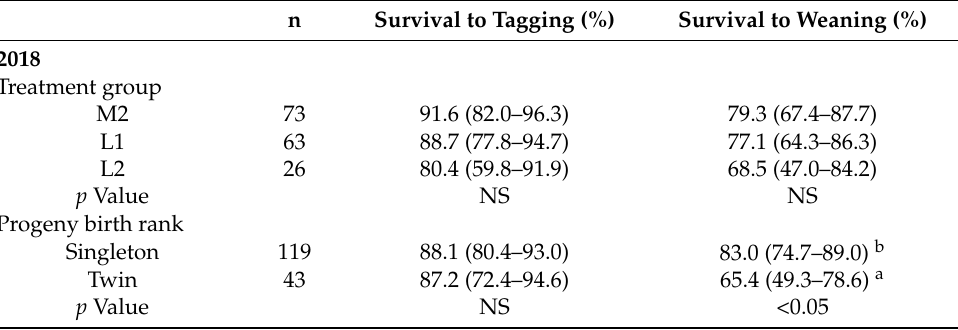
Table 4. Progeny survival (%) at tagging and weaning (L95 and L78 for 2018 and 2019, respectively) for ewes born to mature ewes as twins (M2), born to ewe lambs as singletons (L1) or as twins (L2), and by birth rank of the progeny (singleton, twin, or triplet), during their first (2018) and second (2019) lambings. Values are back-transformed LS means and 95% confidence intervals.